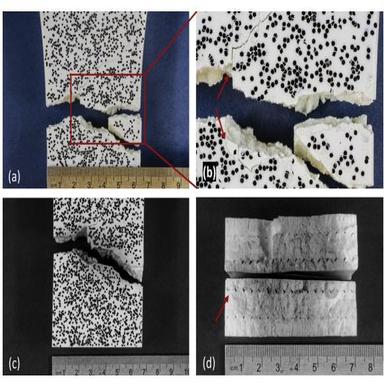
Fracture surface images of SP4 (a,b) and SP5 (c) and (d) crack initation site for SP5.